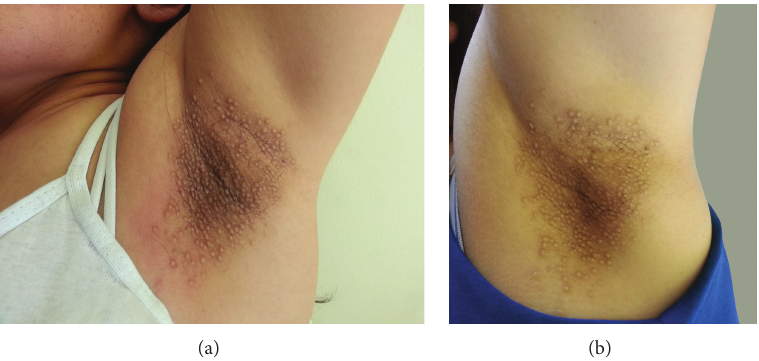
Figure 2: (a) Before treatment and (b) no change after 3 months of topical